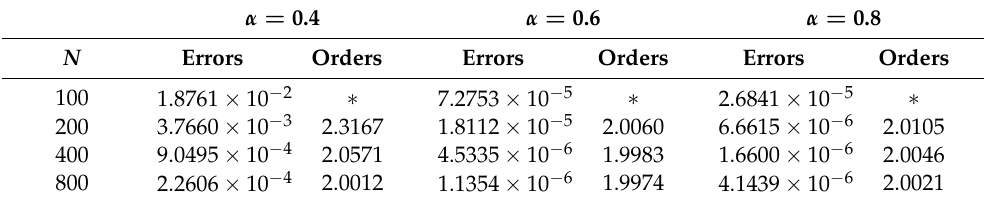
Table 3. Errors and orders in temporal direction for Scheme III (Example 1).